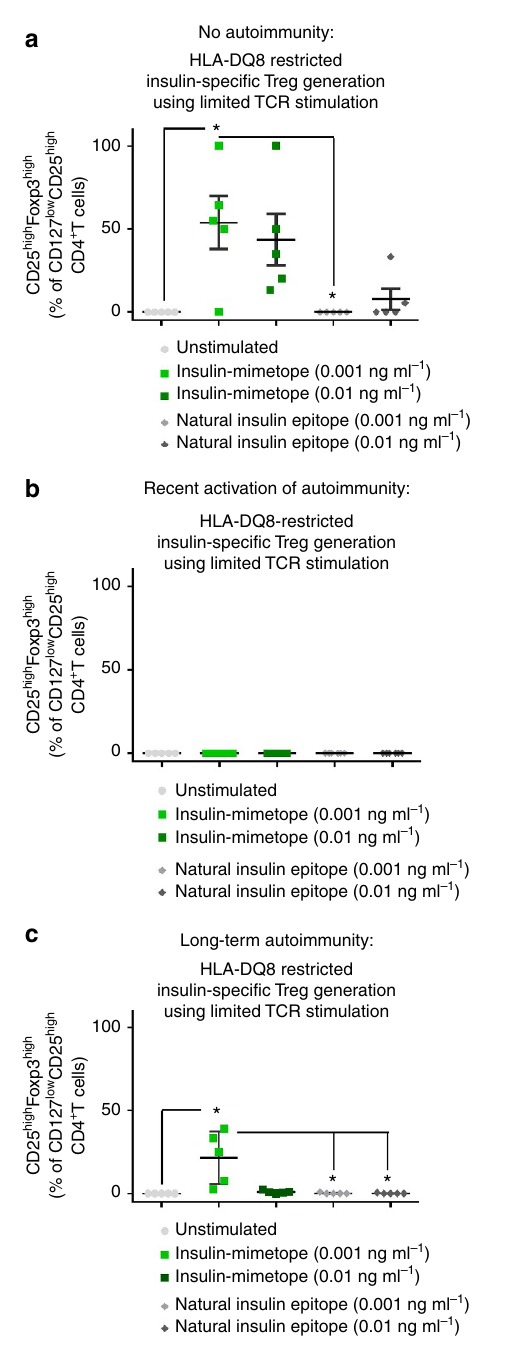
Figure 5 | Human insulin-specific Foxp3 þ Treg induction using insulin mimetopes and subimmunogenic TCR stimulation. Comparison of human Treg induction potential of insulin mimetopes (ins.mim.1 ¼ 14E-21G-22E; ins.mim.4 ¼ 14E-21E-22E) and the natural insulin-B-chain 9-23 epitope using limited TCR stimulation in the presence of autologous CD304 þ plasmacytoid, CD1c þ and CD141 þ myeloid dendritic cells in vitro and human naive CD4 þ T cells purified from children with or without ongoing islet autoimmunity (no autoimmunity, n ¼ 5 per group ( a ); recent activation of autoimmunity, n ¼ 6 per group ( b ); longterm autoimmunity, n ¼ 5 per group ( c )) from duplicate wells done in five independent experiments. Tregs were identified as CD4 þ CD3 þ CD127 low CD25 þ Tcells and then verified by intracellular staining for Foxp3. * P o 0.05 (Student´s t